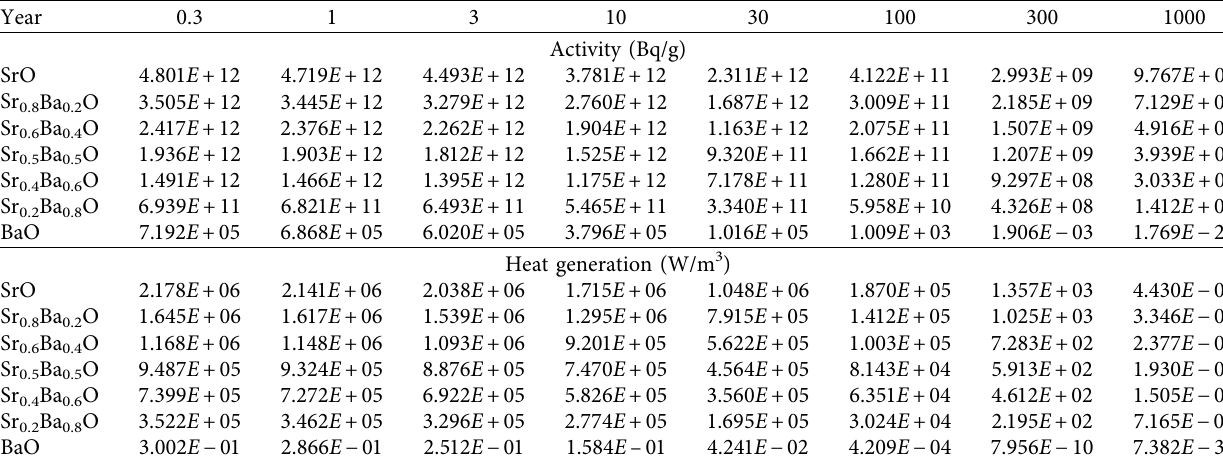
Table 4: Radiological characteristics of Sr waste according to Sr/Ba ratio.